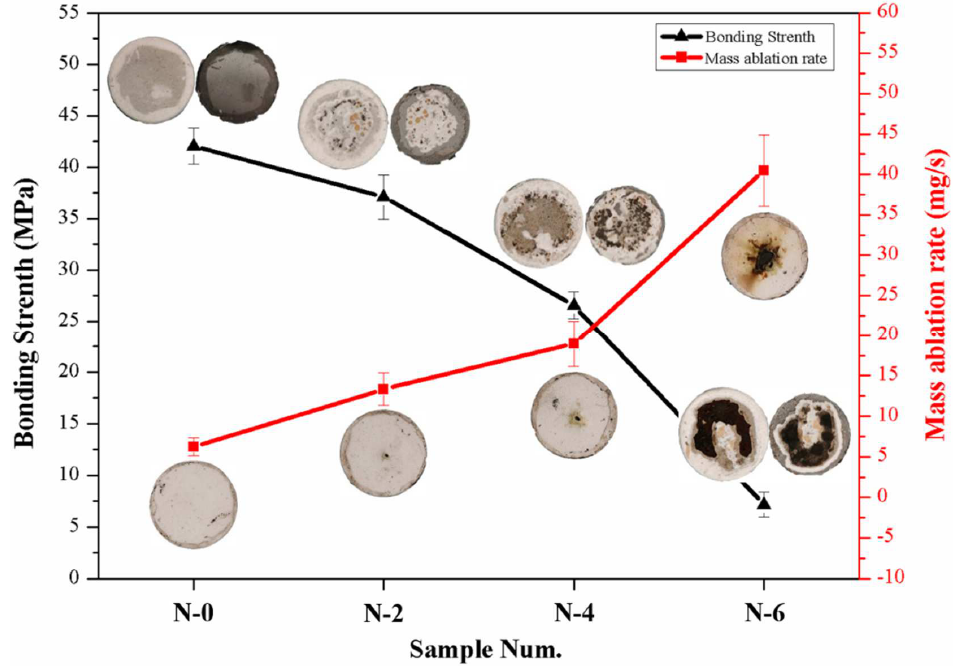
Figure 8. Bonding strengths and mass ablation rates of NiCoCrAlY/MSZ composite coatings before and after NSS